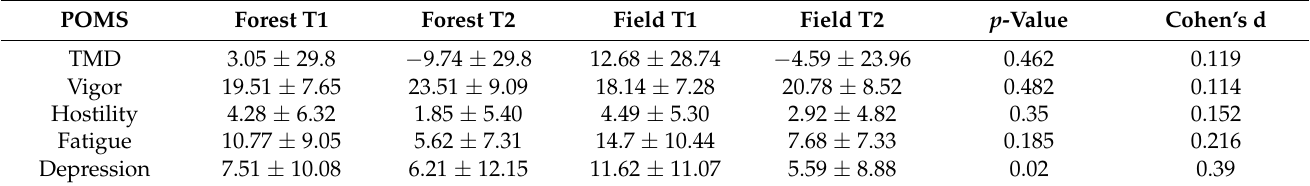
Table 2. Profile of Mood States (POMS n = 39, mean ± SD). TMD = Total Mood Disturbance.